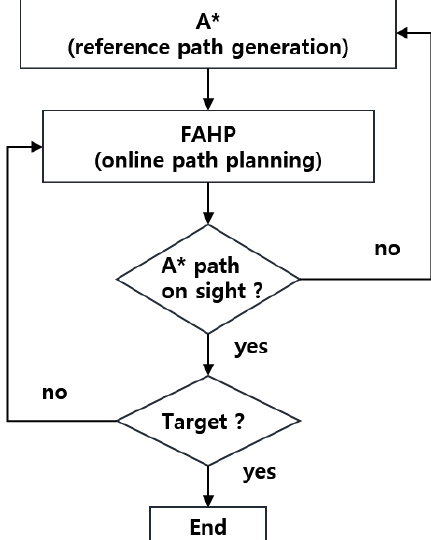
Figure 6. Schematic of the A*–FAHP hybrid path planning algorithm.